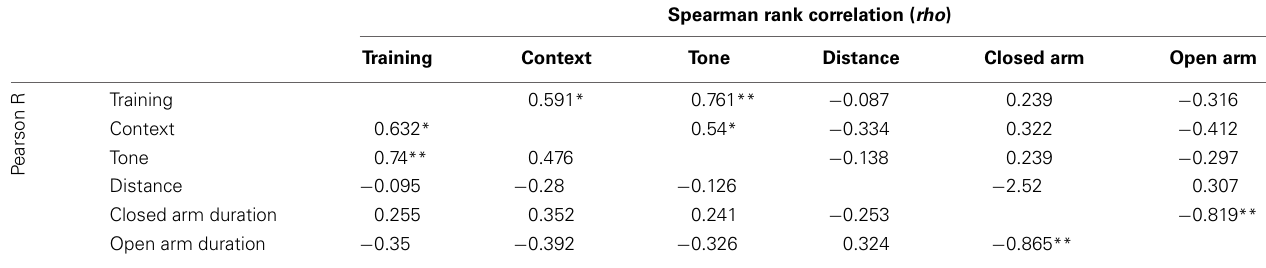
Table 1 | Correlation of traits measured in control population.